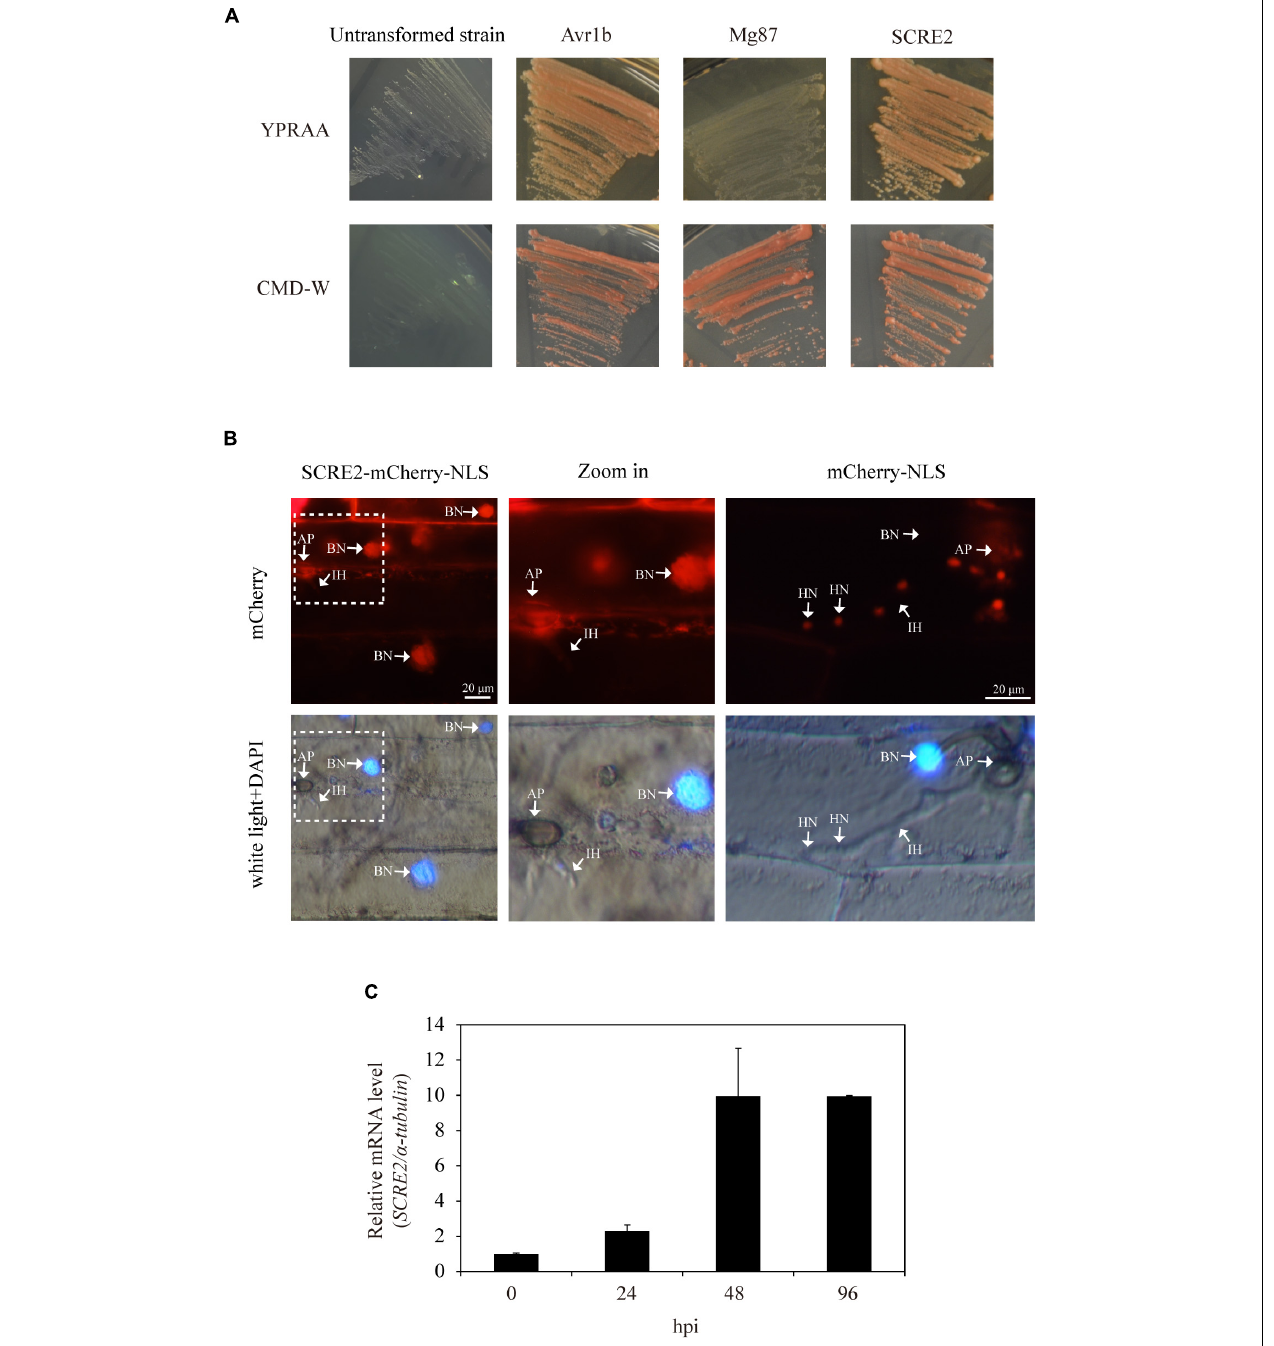
FIGURE 1 | SCRE2 is an effector in U. virens revealed by yeast secretion and cell translocation assays. (A) Functional validation of the signal peptide of SCRE2 by yeast secretion assay. The SCRE2 SP -SUC2 -transformed YTK12 yeast strain was able to grow on YPRAA medium plates with raffinose as sole carbon source. The signal peptide of Avr1b in P. sojae and the N-terminal sequences of Mg87 in M. oryzae were used as positive and negative controls, respectively. The un-transformed YTK12 did not grow on either CMD-W or YPRAA media. Lower panel, yeast growth on CMD-W media showed an equal viability of different transformed strains. (B) The cell translocation assay of SCRE2. The expression of SCRE2-mCherry-NLS in conidia of the transformed M. oryzae P131 strain was confirmed by red fluorescence under fluorescence microscopy (in Supplementary Figure S2 ). Barley leaves were inoculated with the transformed strains and were then incubated in a moist, dark chamber at 28 ◦ C. M. oryzae -infected barley lower epidermal cells were observed at 30 h post-inoculation (hpi) via fluorescence microscopy. DAPI staining showed cell nuclei. NLS, nuclear localization signal; IH, infectious hyphae; AP, appressoria; BN, barley nuclei; HN, hyphal nuclei. (C) Expression pattern of SCRE2 during U. virens infection of the susceptible rice cultivar LYP9. The U. virens -inoculated panicles of the cultivar LYP9 were collected at 0, 24, 48 and 96 h post-infiltration (hpi) for gene expression analyses using quantitative real time RT-PCR assays. Data are means ± standard errors (SE). The α -tubulin gene was used as an internal